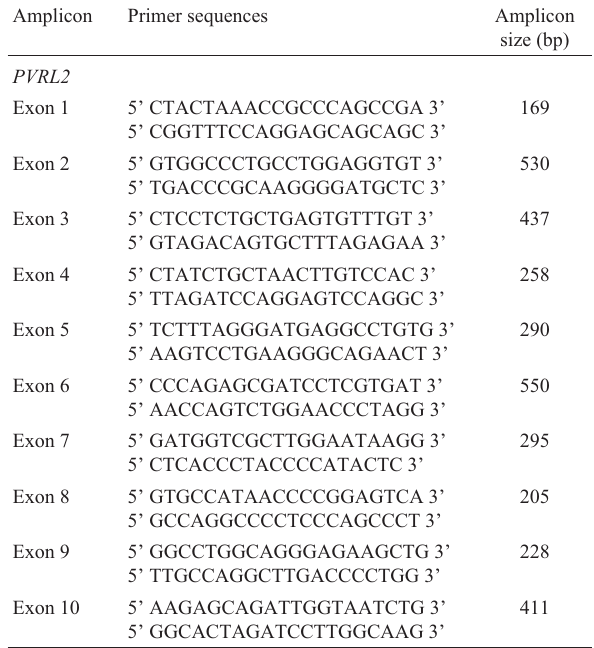
Table 1 - Oligonucleotide primers for PCR amplification of the exons of PVR and PVRL2 . Amplicon Primer